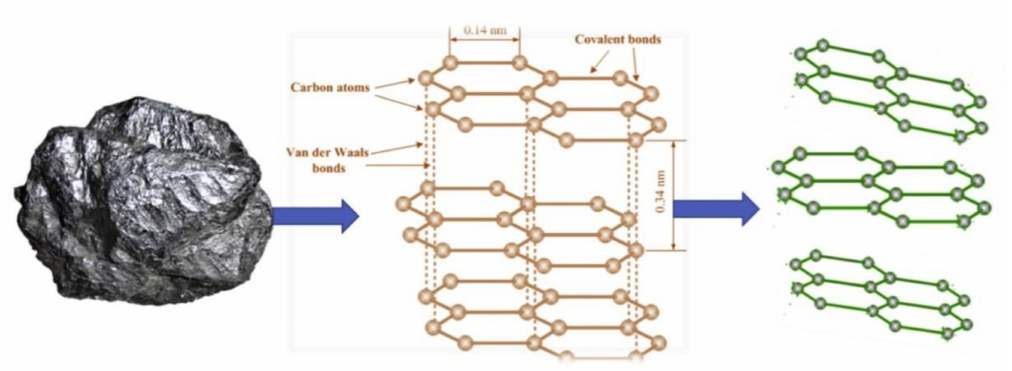
Figure 3. Schematic transformation of graphite in graphene. Reprinted from [107] with permission of